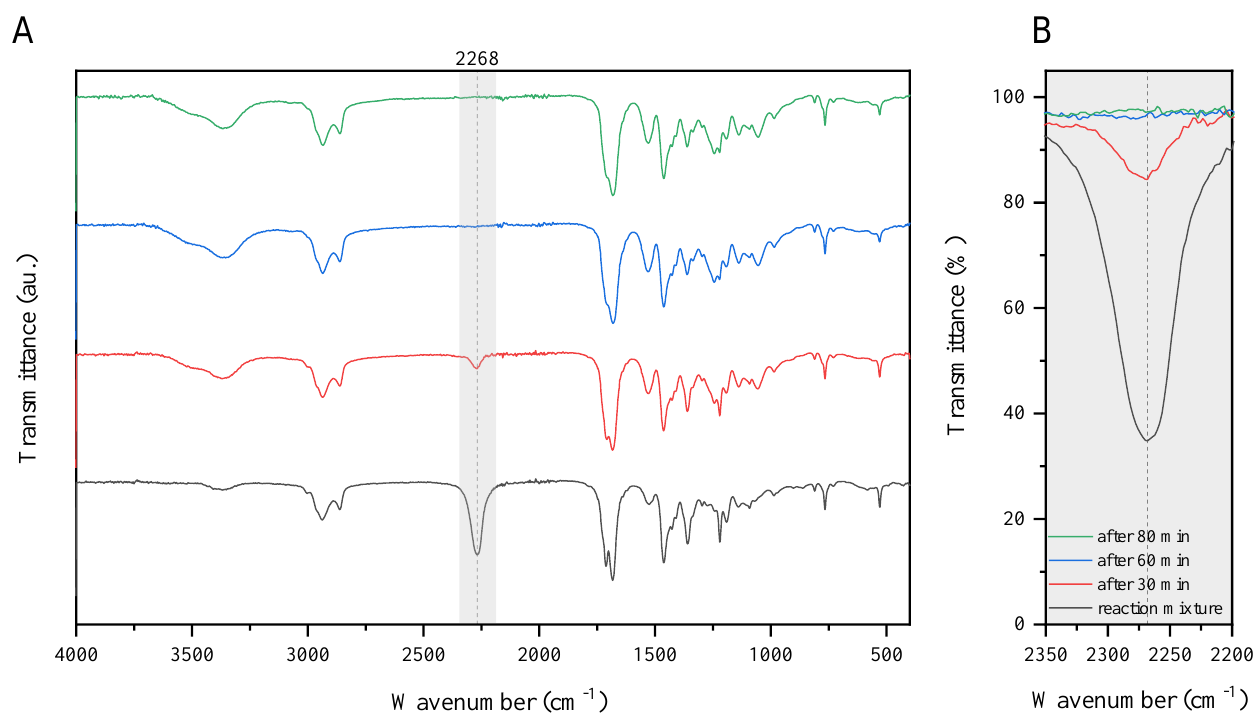
Figure 2. FTIR spectra of 2DB-UA-A prepolymers collected throughout the reaction time ( A ) and monitoring of the disappearance of the peak corresponding to the isocyanate groups ( B ).